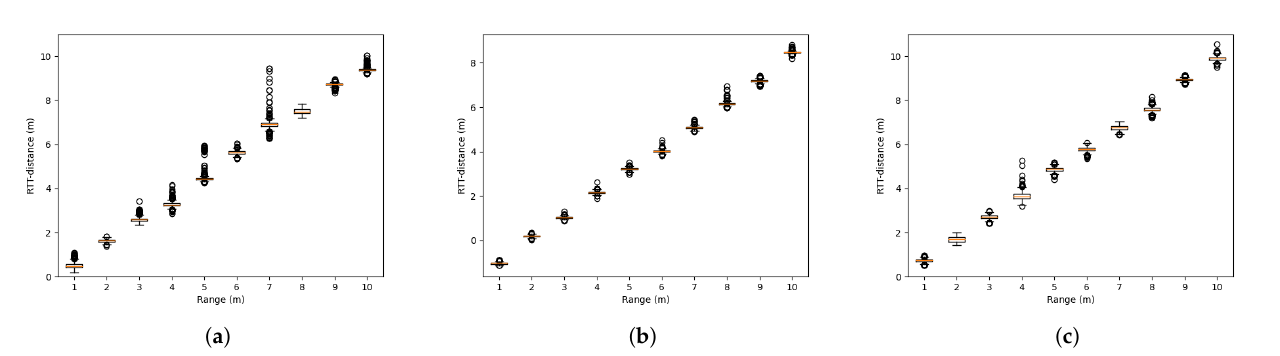
Figure 7. Raw Wi-Fi RTT distance measured by the three smartphones in RFPF and LOS condition: